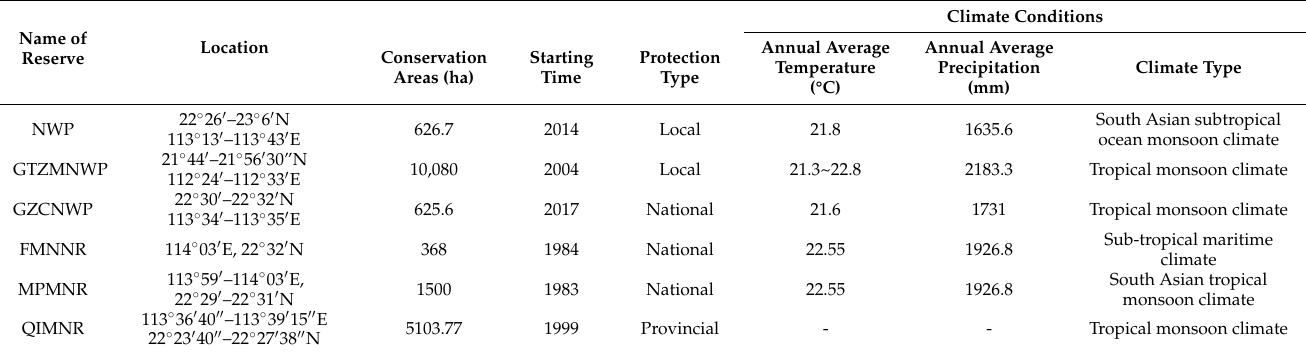
Table 1. Overview of the features used for mapping